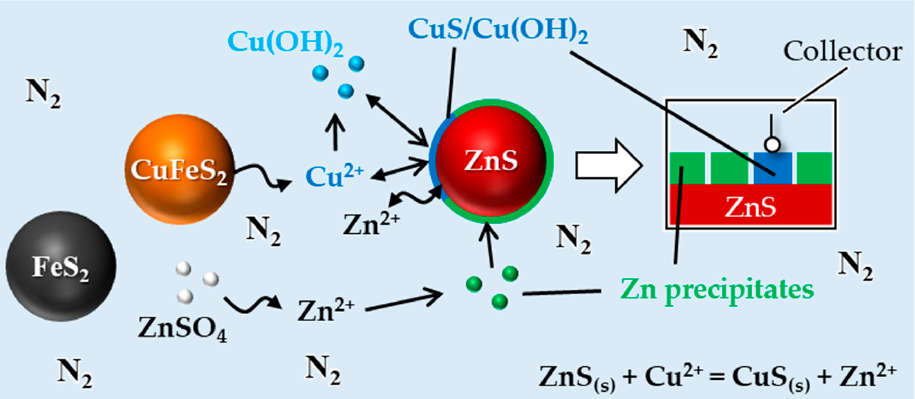
Figure 12. A schematic diagram of the proposed efficient method to depress sphalerite in flotation of Cu ores containing sphalerite and pyrite with zinc sulfate.